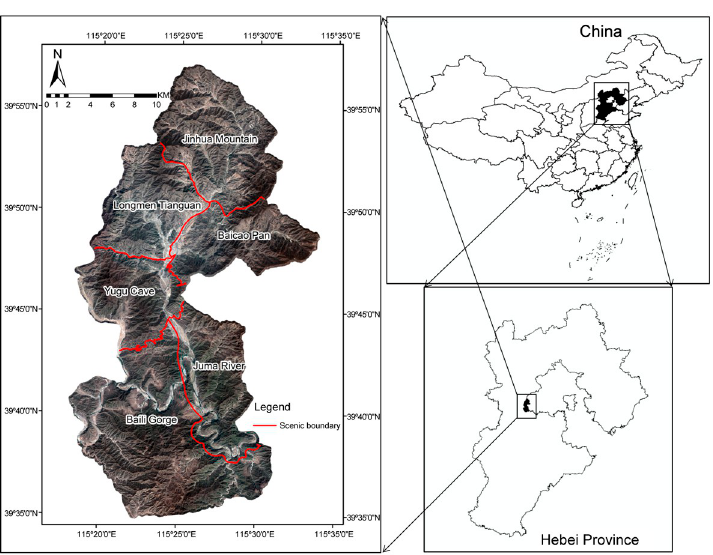
Fig 1. RS image of Yesanpo National Park (Republished from [https://directory.eoportal.org/web/eoportal/ satellite-missions/g/gaofen-2] under a CC BY license, with permission from [Hebei Zhongke Sino Star Information Technology Co., Ltd], original copyright